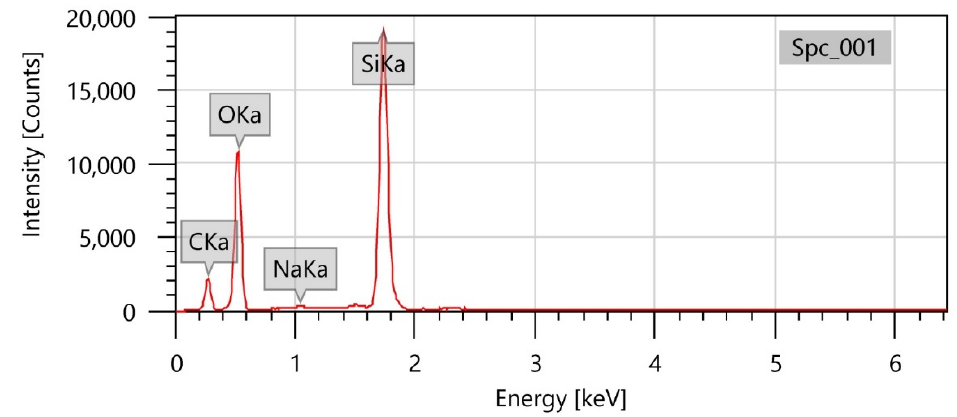
Figure 4. Elemental composition of SiO 2 nano-additives.